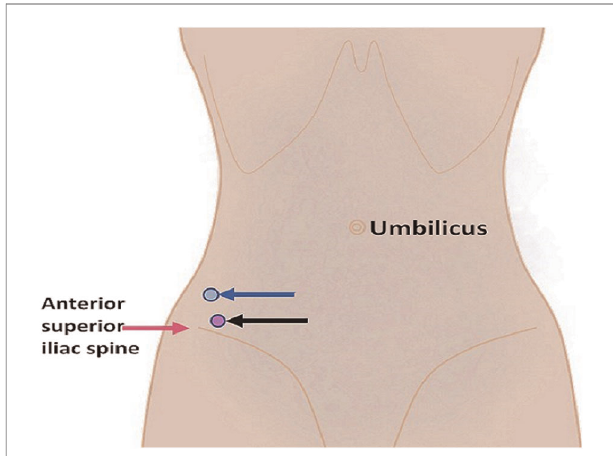
FIGURE 2 | Diagram illustrating the puncture sites for the psoas abscess (blue arrow) and the iliacus muscle abscess (black arrow).